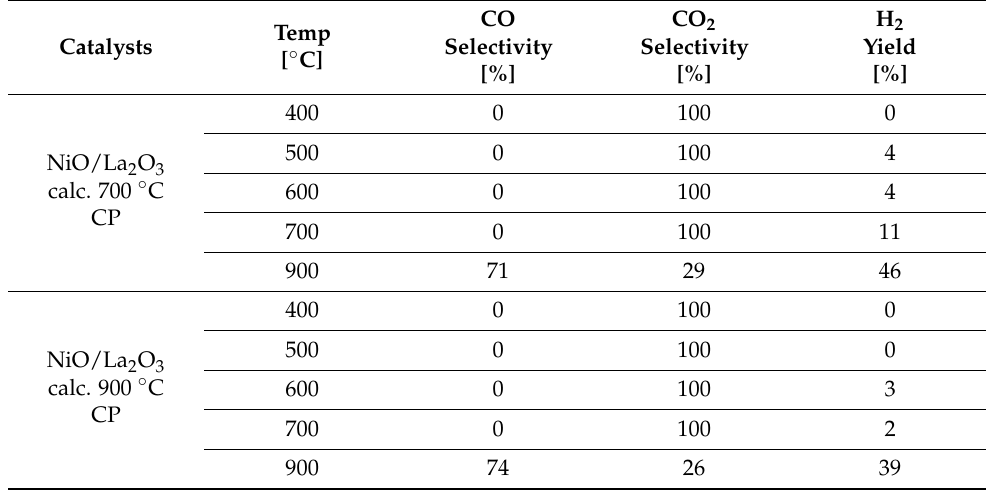
Table 2. The hydrogen yield and selectivity values to CO and CO 2 obtained in the oxy-steam reforming of LNG process over NiO/La 2 O 3